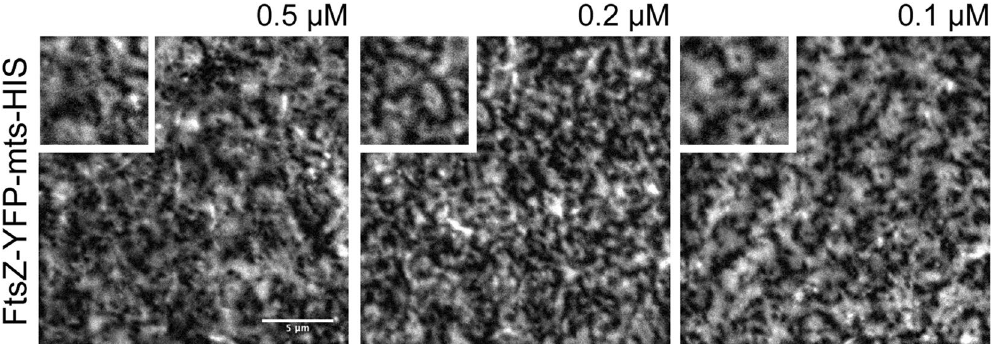
Figure 4. In vitro reconstitution of FtsZ membrane tethering mediated by ZipA, using an FtsZ-YFP-mts- His 6 -tag chimera protein. Representative snapshots of varying concentrations of FtsZ-YFP-mts-His 6 -tag, reconstituted on ( E. coli polar lipids) supported membranes doped with 1% DGS-NTAP, in the presence of 4 mM GTP and 5 mM Mg 2 + . Small panel upper left, zoom in from each